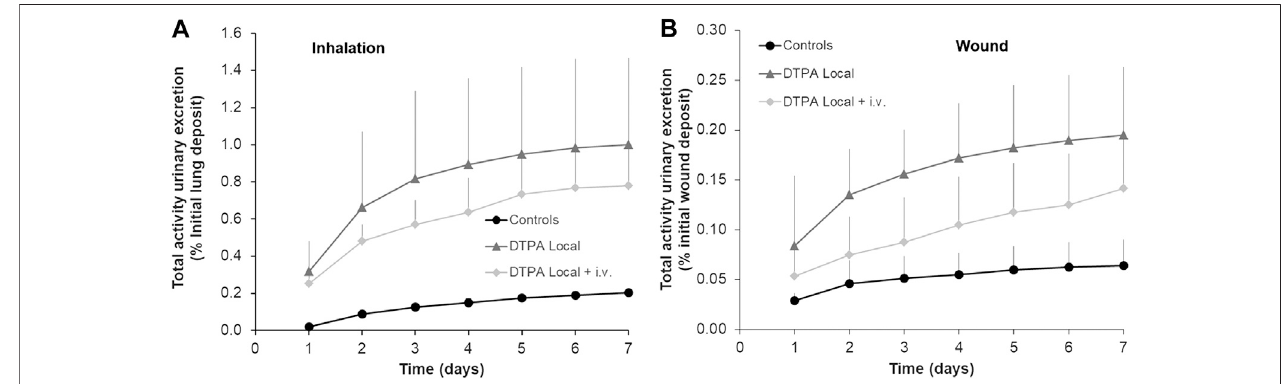
FIGURE 4 | Effect of local DTPA or local DTPA followed by DTPA systemic administrations on cumulative urinary activity excretion following lung (A) or wound contamination (B) withMOX.AnimalswerecontaminatedwithMOX eitherbyinhalation(12 kBq)ordeposited inawound(13 kBq) asdescribed.Local administration to lungs (DTPA powder about 5 µmol/kg) or wound (DTPA solution 30 µmol/kg) was started at 2 h ( “ DTPA Local ” ). For combined local and systemic DTPA treatment ( “ DTPA Local + i.v. ” ), animals received the local dose at 2 h then two intravenous DTPA per week from day one to day 20 (30 µmol/kg). Data are expressed as a percentage of the initial lung or wound deposit and are the means ± S.D. of 3 – 6 animals.